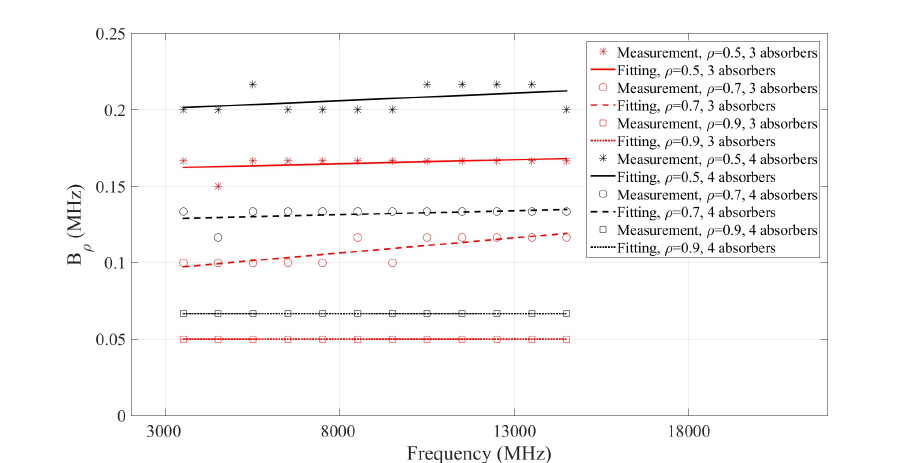
Figure 11. (color online) Coherence bandwidth in the NIM RC calculated over a 1 GHz bandwidth as a function of center frequency.